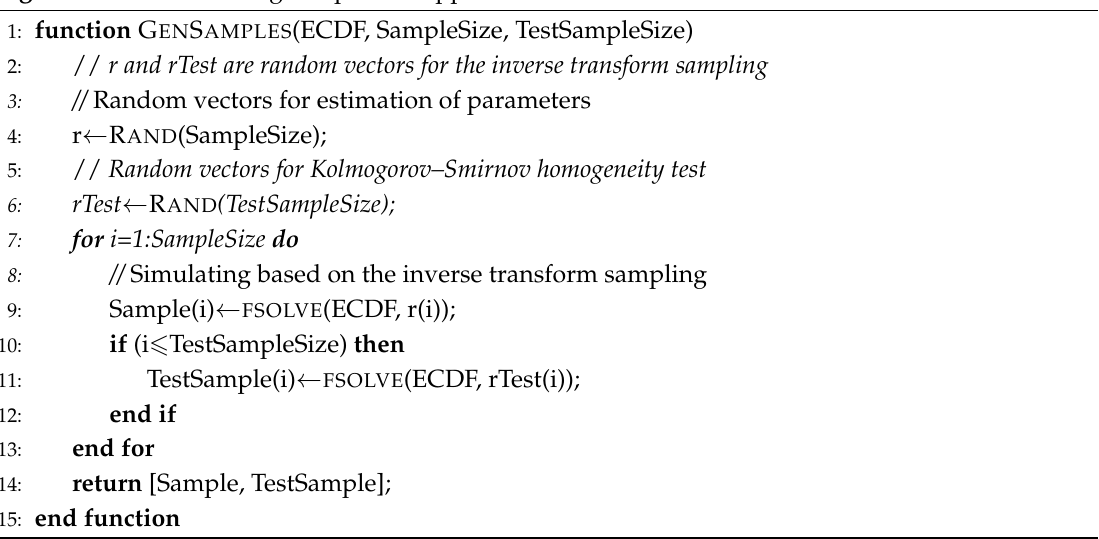
Algorithm A1. Simulating samples for approximation and statistical